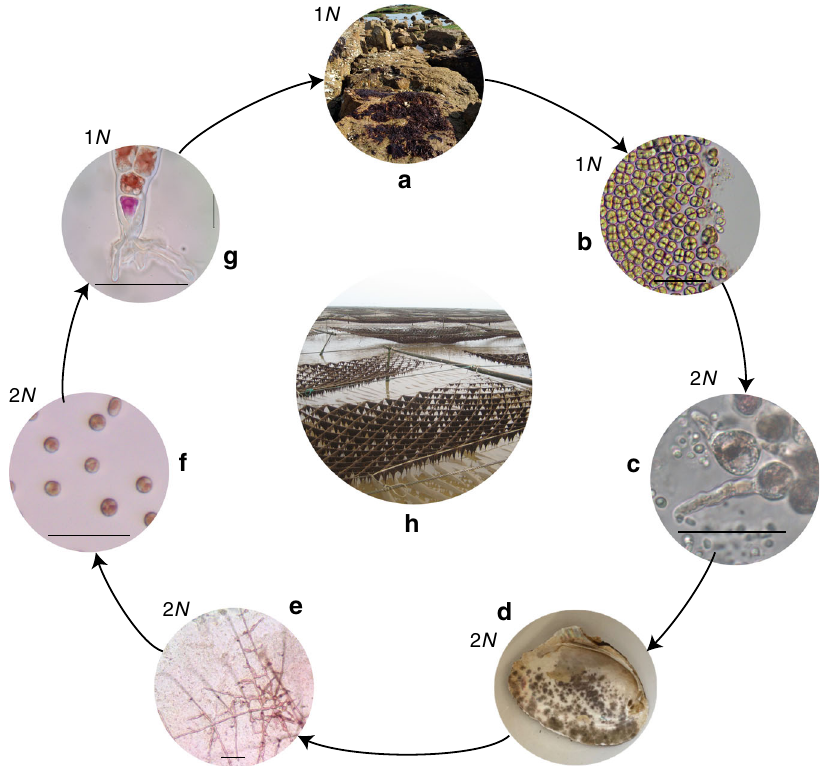
Fig. 1 The life cycle of P. yezoensis showing the alternation of heteromorphic generations inhabiting distinctive niches. Ploidy was added as “ 1 N ” and “ 2 N ” in the upper left corner of each subgraph. a Gametophyte thalli adhered to rocks are exposed to air during low tide. b Carpospores and sperms form in mature thalli; c released zygotospores, showing one with a germ tube. d Purple patches on oyster shell are boring sporophyte conchocelis. e Swelling fi lamentous conchocelis that are going to produce conchosporangia. f Released conchospores. g Thallus seedling with a holdfast formed at the base. h P. yezoensis nets in mariculture farms. Scale bars in b , c , and e – g 50 μ m. Asexual reproduction is not shown here. Microscope observation in b , c and e , g were repeated independently on multiple Pyropia samples ( n > 10) showing similar